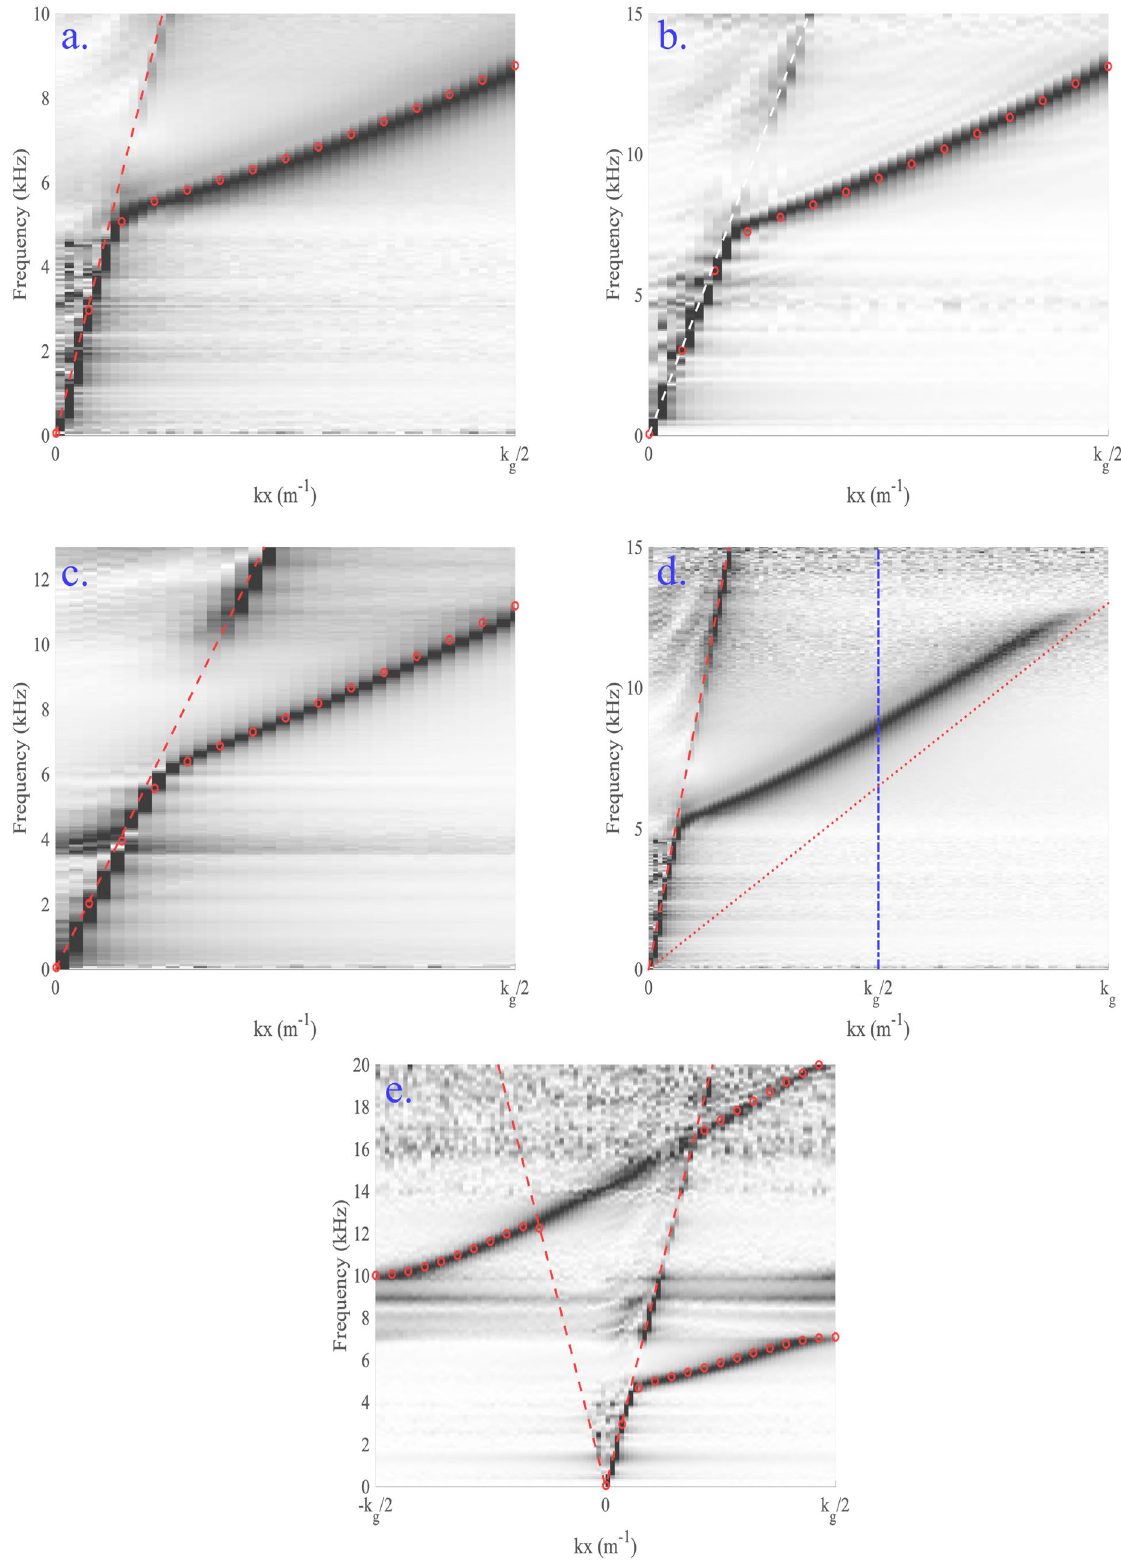
Figure 3. Dispersions of the partly covered meander structures. Grey scale shows experimental data, and red circles the modelled results. The red dashed line shows the free-space sound-lines. ( a – c ). The experimental dispersions for the three samples in the first 10 0.8 (cid:31) (cid:31) 1 0 1 4 4 Brillouin zone, ( a ) mm, W = mm, L m = mm, L o = mm and s = mm, ( b ) mm, W = mm, g = g = L m = 5 mm, L o = 0.8 mm and s = 0 mm, ( c ) (cid:31) g = 6 mm, W = 2 mm with L m = 5 mm, L o = 0.8 mm and s = 0 mm. ( d ) The dispersion presented in ( a ) extended past the first Brillouin zone boundary (dot dashed blue line) also showing the meander 0.5 3.6 mm, s = sound-line (red dotted line). ( e ) Data for the sample used in ( a ) with L o =